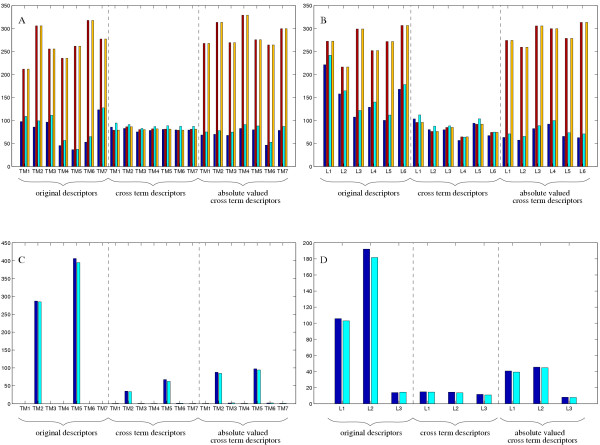
Hit rates. A The hit rates for the receptor blocks in the amine data set. The figure shows for each transmembrane region the hit rates for the original receptor descriptors, the cross term descriptors and the absolute valued cross term descriptors involving that transmembrane region. B The hit rates for the ligand blocks in the amine data set. The figure shows for each ligand descriptor block the hit rates for the original receptor descriptors, the cross term descriptors and the absolute valued cross term descriptors involving that ligand descriptor block. C and D The corresponding hit rates for the alpha data set. The blue bars show the hit rates computed for the PLS models using PLSfilter, the cyan bars show the hit rates computed for the PLS models using corrfilter, the red bars show the hit rates computed for the RR models using PLSfilter, and the yellow bars show the hit rates computed for the RR models using corrfilter